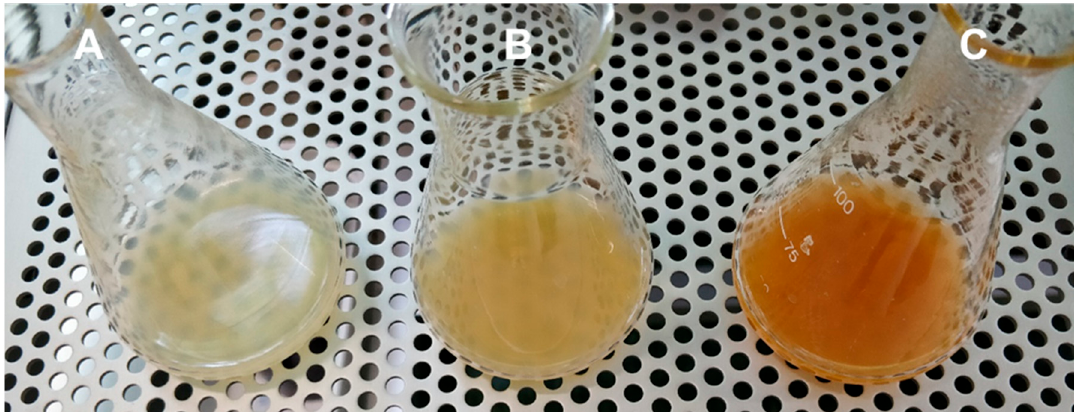
Figure 3. Visual difference between type I and II Fenton reactions (end of reaction). ( A ): Type II that failed to initialize boiling. ( B ): Type II which initialized boiling. ( C ): Type I.